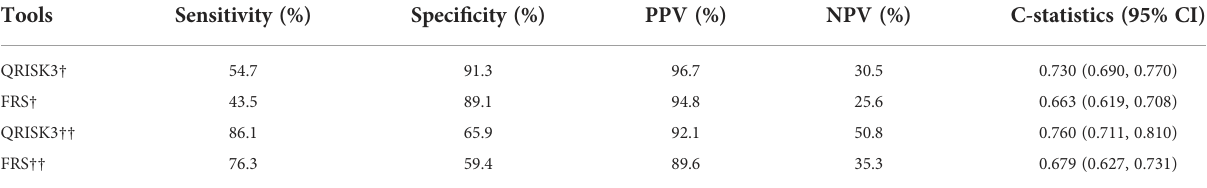
TABLE 5 Sensitivity, speci fi city, PPV, NPV and C-statistics of QRISK3 and FRS (patients with loss to follow-up were classi fi ed as the non-CVD group). Tools